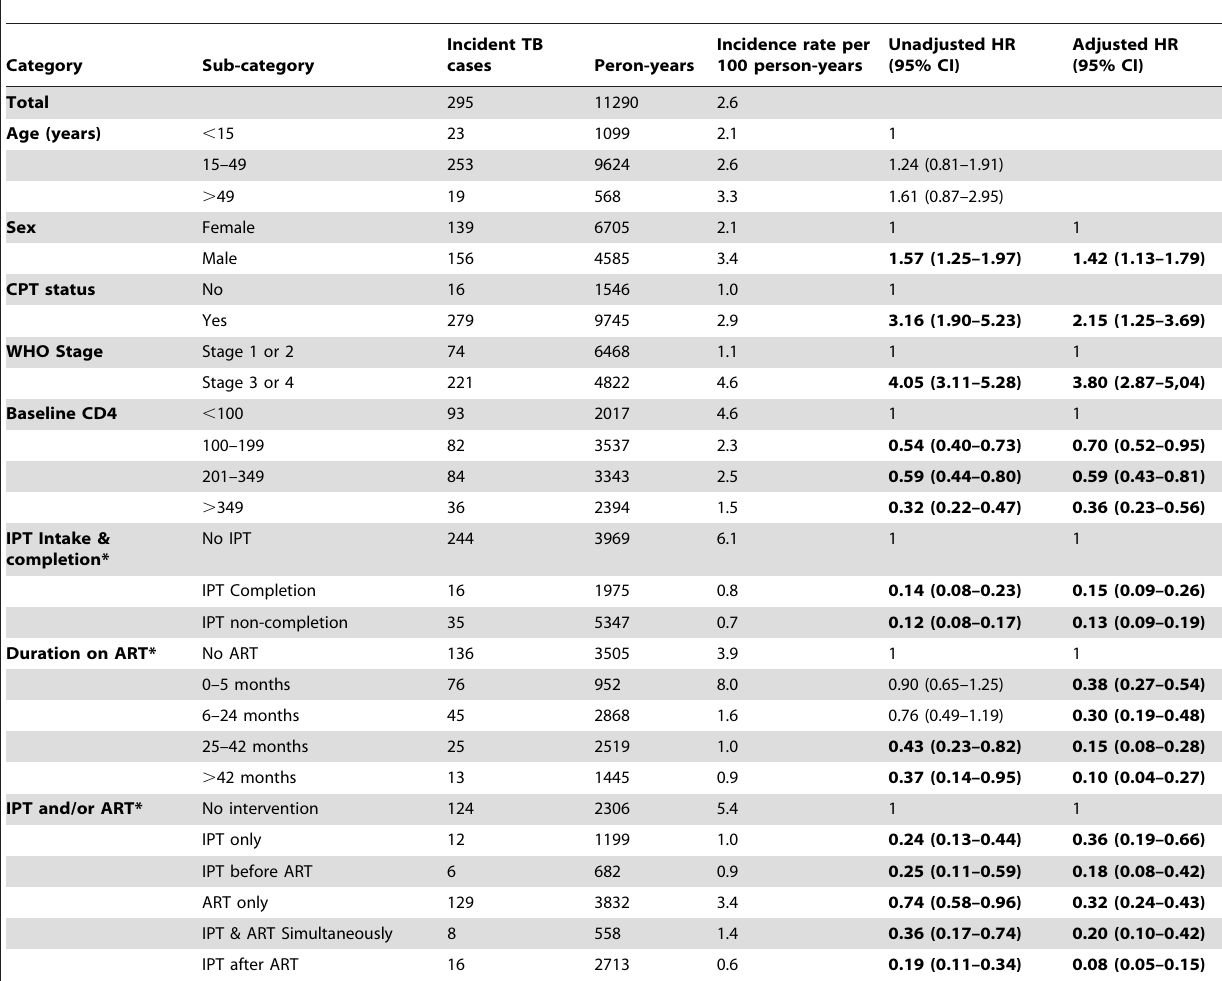
Table 3. Incidence rate of TB among HIV infected patients in Chronic HIV care in SNNP region, Ethiopia, September 2007 to August 2010.